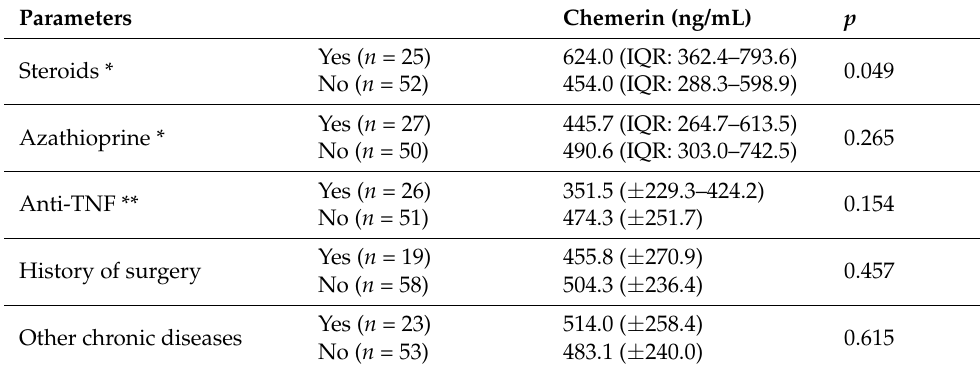
Figure 2. The serum level of chemerin in patients before and after anti-TNF therapy. Solid line: de- creased concentration; dashed line: increased concentration.